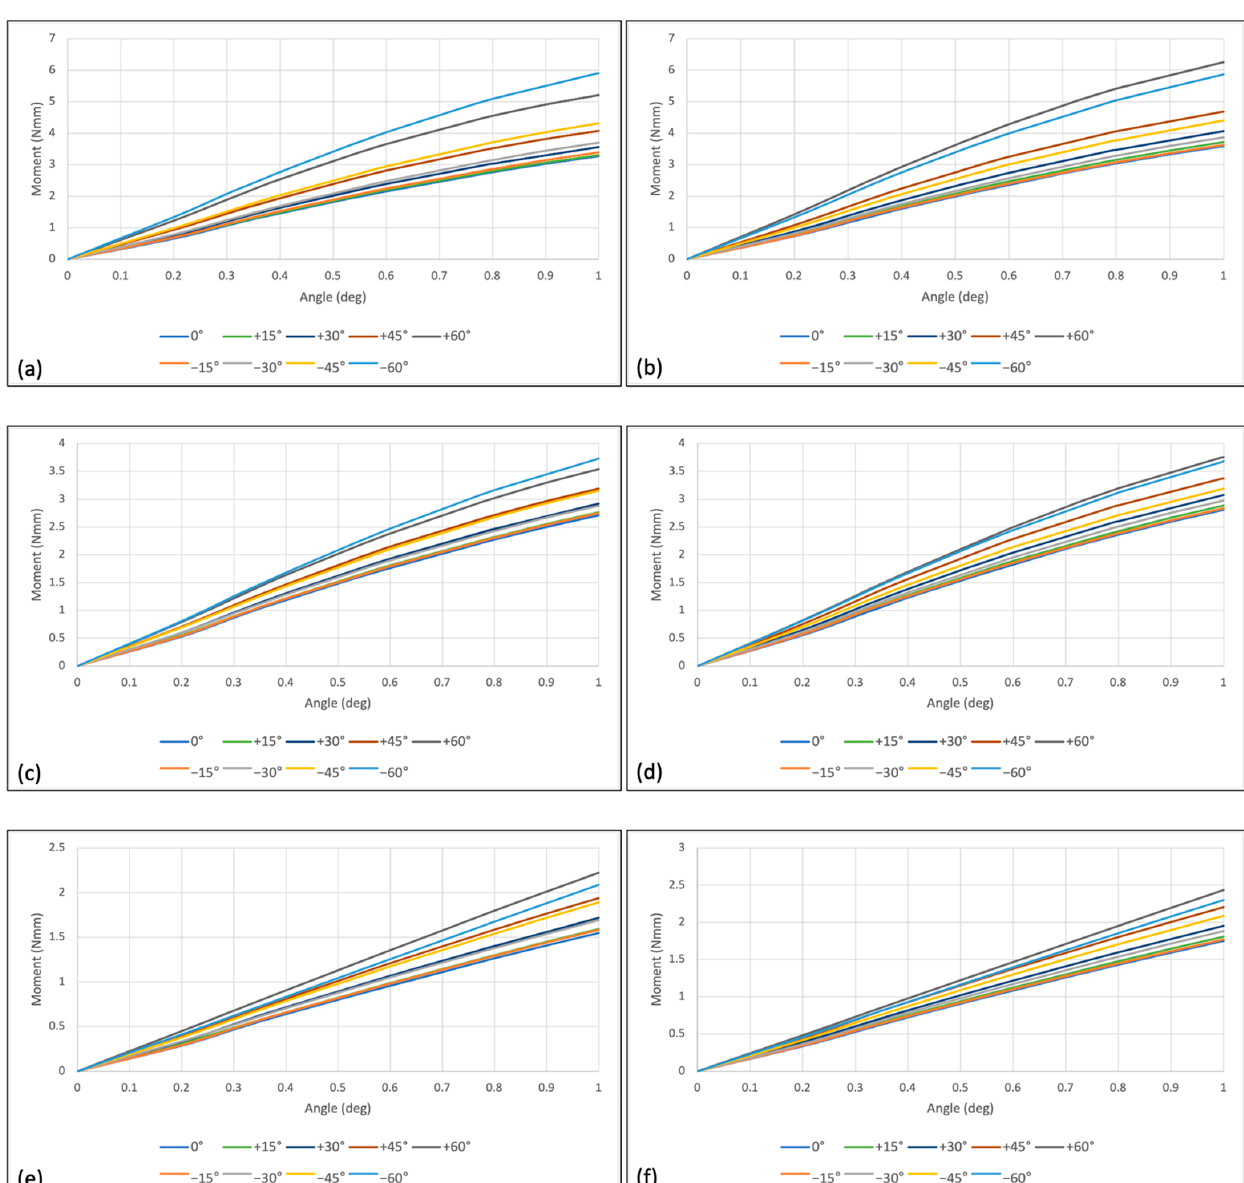
Figure 9. Moment required to unwind the miniscrew for 1 ° in counter-clockwise direction in centrical and eccentric hole groups: ( a ) overall moment in the centric hole group; ( b ) overall moment in the eccentric hole group; ( c ) moment at the cortical bone in the centric hole group; ( d ) moment at the cortical bone in the eccentric hole group; ( e ) moment at the trabecular bone in the centric hole group; ( f ) moment at the trabecular bone in the eccentric hole group.